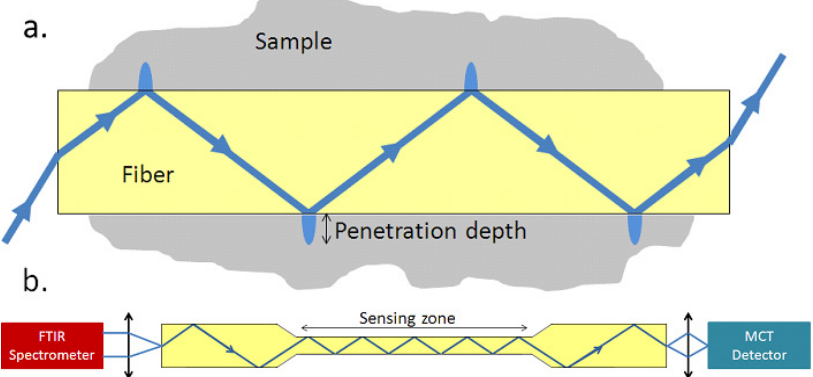
Figure 2. ( a ) Mechanism of fiber evanescent wave spectroscopy (FEWS); ( b ) General set up of FEWS and the scheme of a tapered